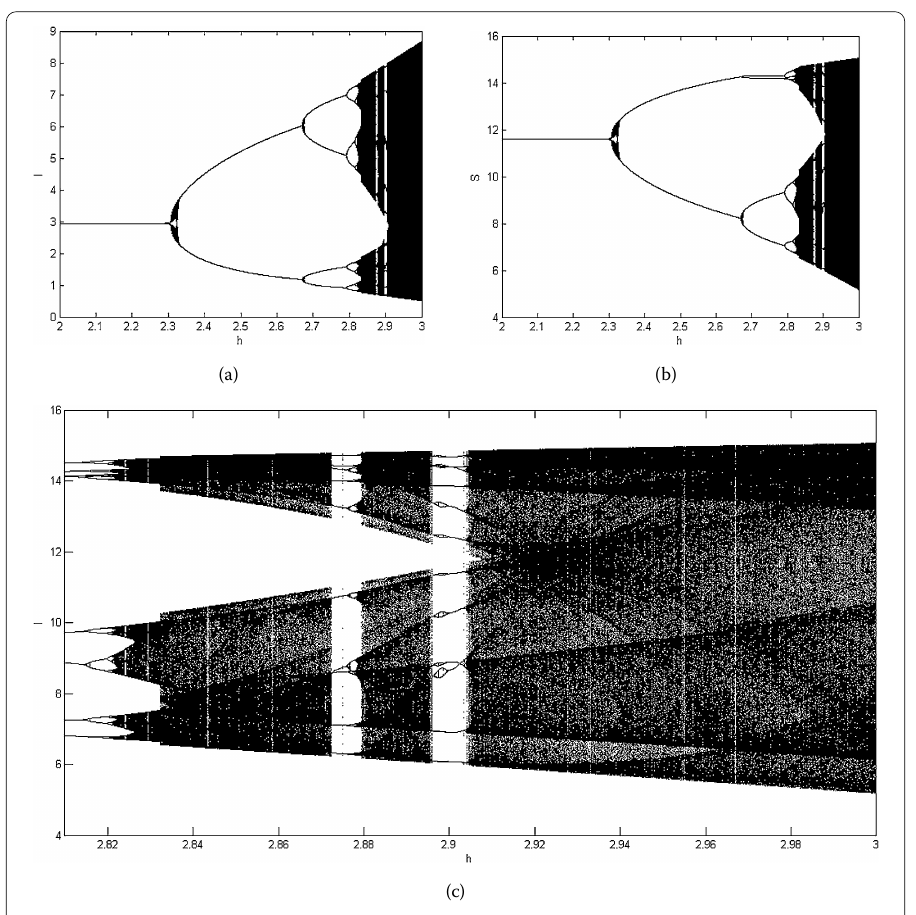
Figure 1 Flip bifurcation diagram of model (3.7) for h ∈ [2,3] with local amplification to